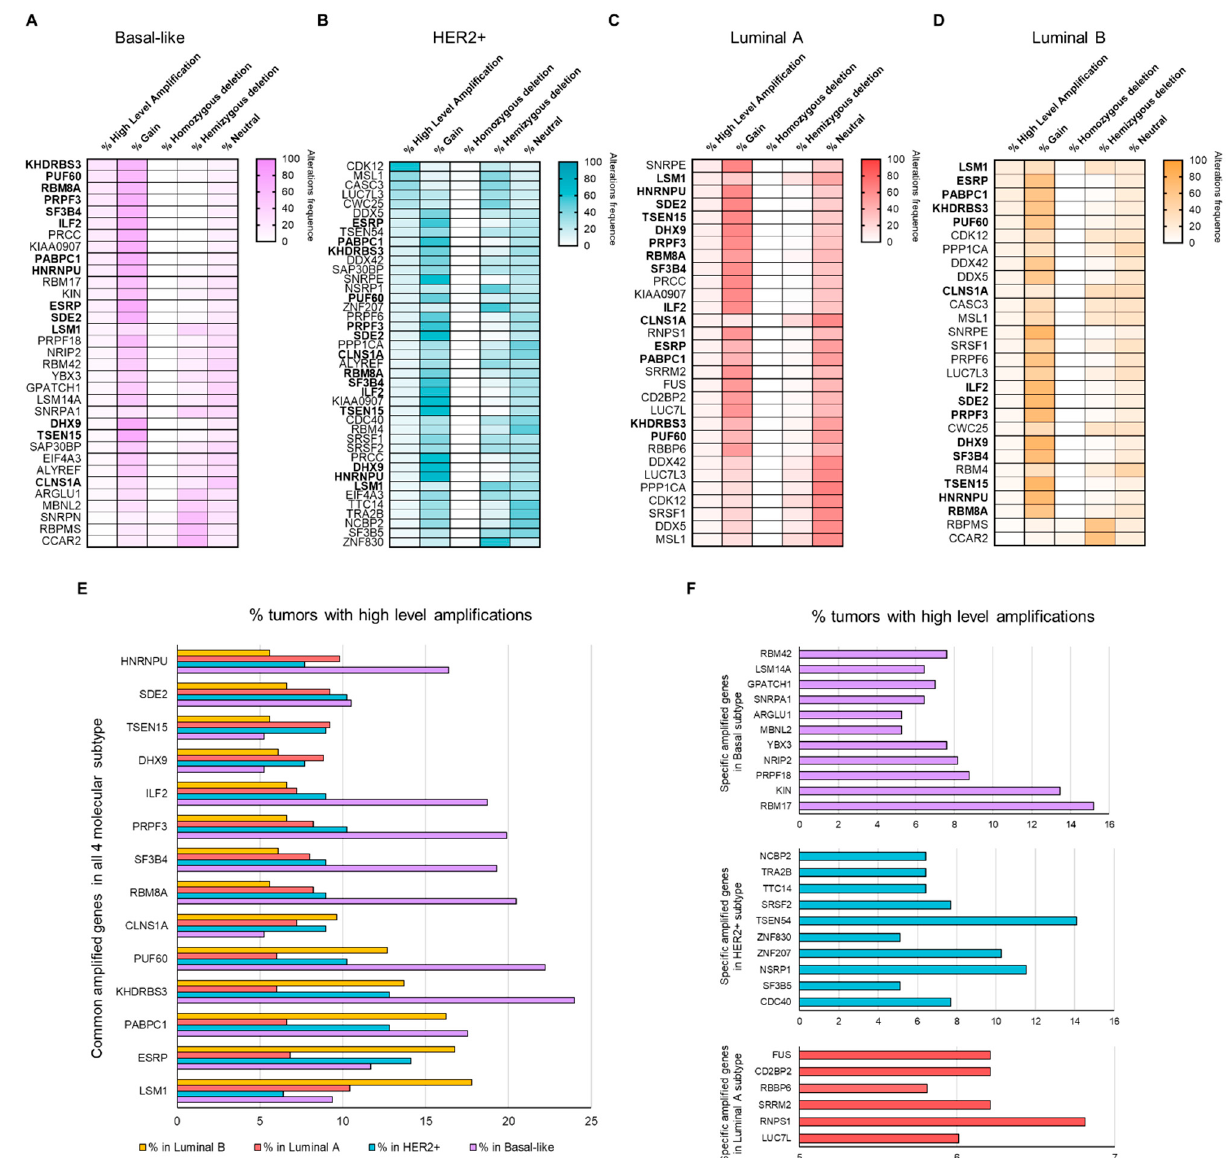
Figure 2. Copy number alteration frequencies in splicing-related genes: list of genes with high amplification in >5% of tumors for Basal ( A ), HER2+ ( B ), Luminal A ( C ), and Luminal B ( D ) molecular subtypes. In total, 14 common splicing- related genes showed high level amplification in >5% of tumors, shown in bold font. Percentage of tumors with presence of amplifications in >5% of tumors in splicing-related genes both common in all molecular subtypes ( E ) and specific in each subtype ( F ).